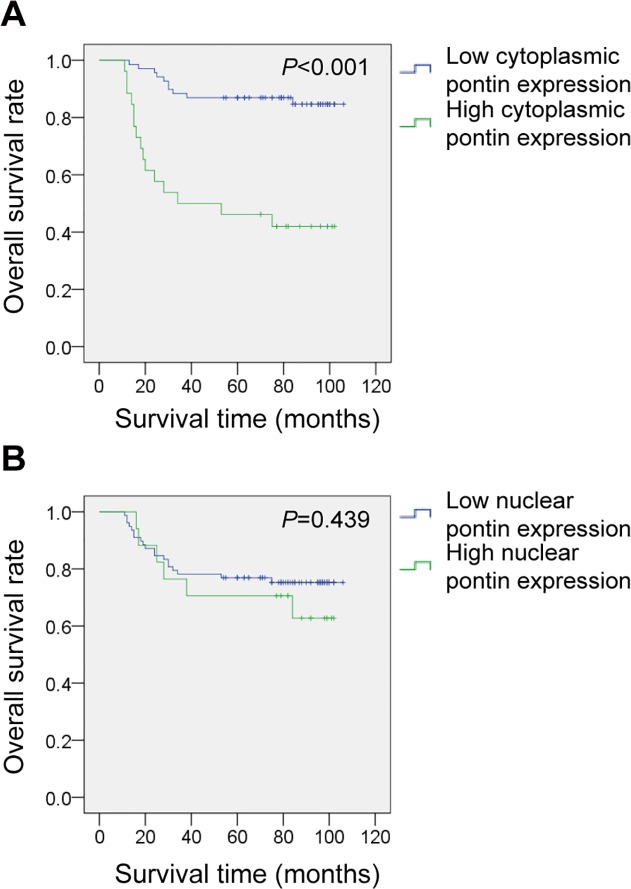
Kaplan-Meier curves of overall survival stratified by cytoplasmic pontin expression status.(A) and nuclear pontin expression status (B). P-value was calculated by log-rank test.